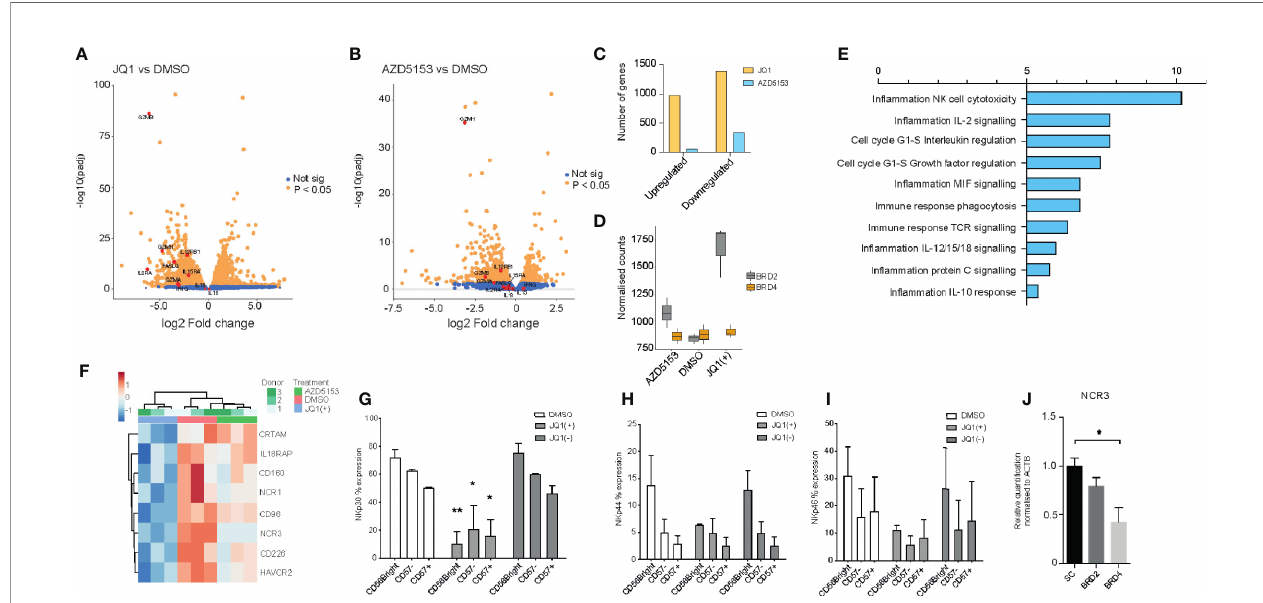
FIGURE 4 | JQ1(+) and AZD5153 impact on NK cell in fl ammatory function. NK cells were cultured in the presence of IL-15 (10 ng/ml) and treated with either DMSO, JQ1(+) or JQ1( − ) for 24 h. (A) A volcano plot showing the gene expression differences between JQ1(+) and DMSO treated NK cells. (B) A volcano plot showing the gene expression differences between AZD5153 and DMSO treated NK cells. (C) A Bar chart showing the number of upregulated and downregulated genes following JQ1(+) or AZD5153 treated NK cells. (D) Box plots showing the normalized counts of BRD2 and BRD4 following treatment with DMSO, JQ1(+) or AZD5153. (E) Pathway enrichment analysis showing the metacore process pathways for the differences in gene expression between JQ1(+) and AZD5153 treated NK cells. (F) Heatmap of gene expression changes in three individual NK cell donors upon treatment with either DMSO, JQ1(+) or JQ1( – ). The percent expression of NKp30 (G) , NKp44 (H) and NKp46 (I) as measured by fl ow cytometry. (J) The relative quanti fi cation of NCR3 following culture with scrambled control (SC), BRD2 or BRD4 LNA, as measured by qPCR. Data in (G – I) represents mean ± S.D. and is measured in three independent donors. P values were calculated using Kruskal – Wallis with Dunn ’ s multiple comparison test *P < 0.05, **P <